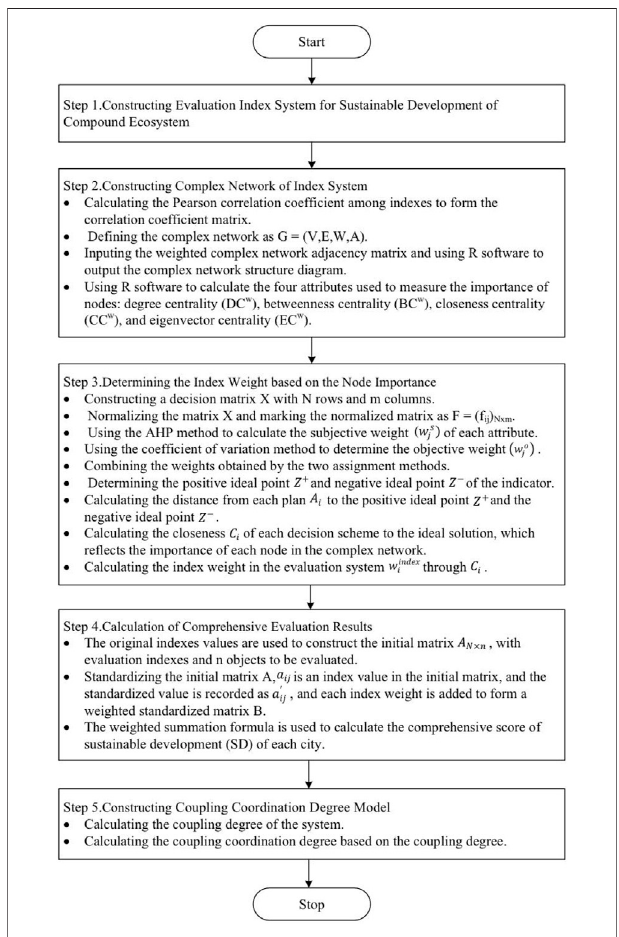
FIGURE 2 | Flowchart of evaluation model.